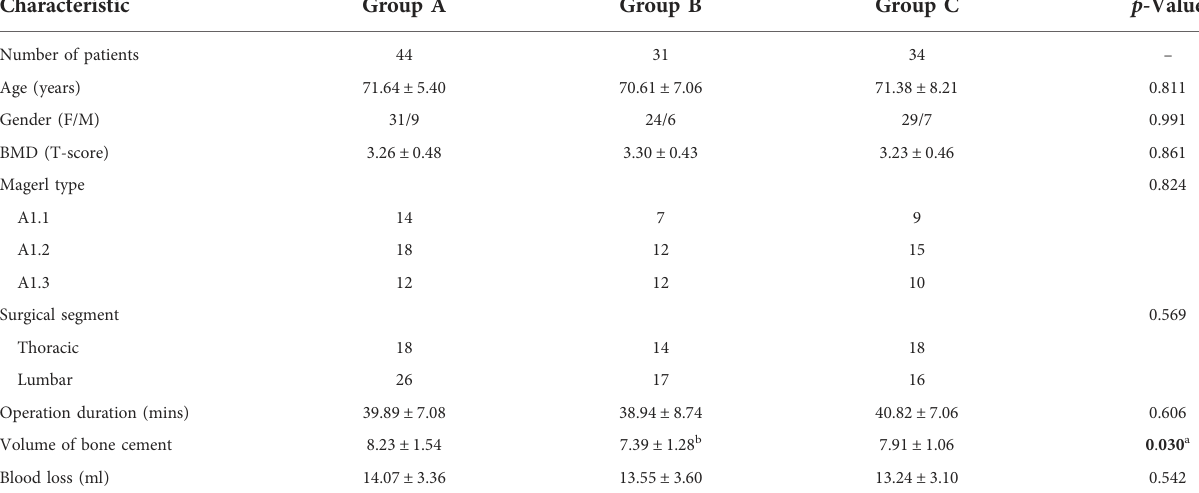
TABLE 1 General characteristics of the patients.